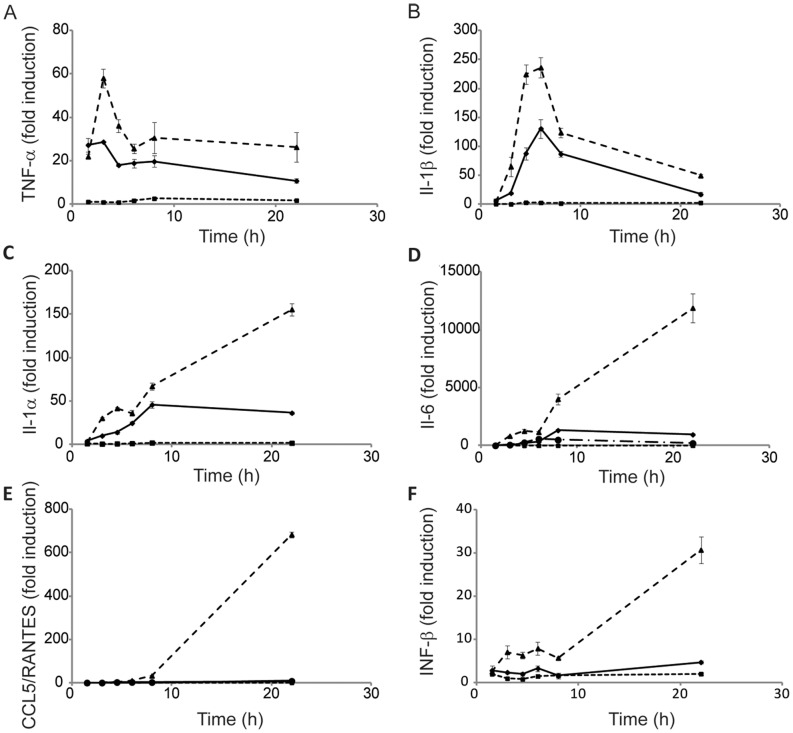
qRT-PCR analysis of macrophage gene expression.Tlr4+/+ HeNC2 cells were stimulated with either LTA (2 µg/ml, diamonds, solid line), Hb (50 µg/ml, squares, short dashes), LTA+Hb (2 µg/ml and 50 µg/ml, respectively, triangles, long dashes) or maintained in medium for the indicated time period and then analyzed by qRT-PCR for TNF-α (A), IL-1β (B), IL-1α (C), IL-6 (D), CCL5/RANTES (E) or IFN-β (F) mRNA levels compared to control. Tlr4d/d GG2EE cells were stimulated with LTA+Hb (2 µg/ml and 50 µg/ml, respectively; circles, dashes and dots) and assayed for IL-6 (D) or CCL5/RANTES (E). These results denote mean +/− standard error (n = 3) and are representative of three independent experiments.